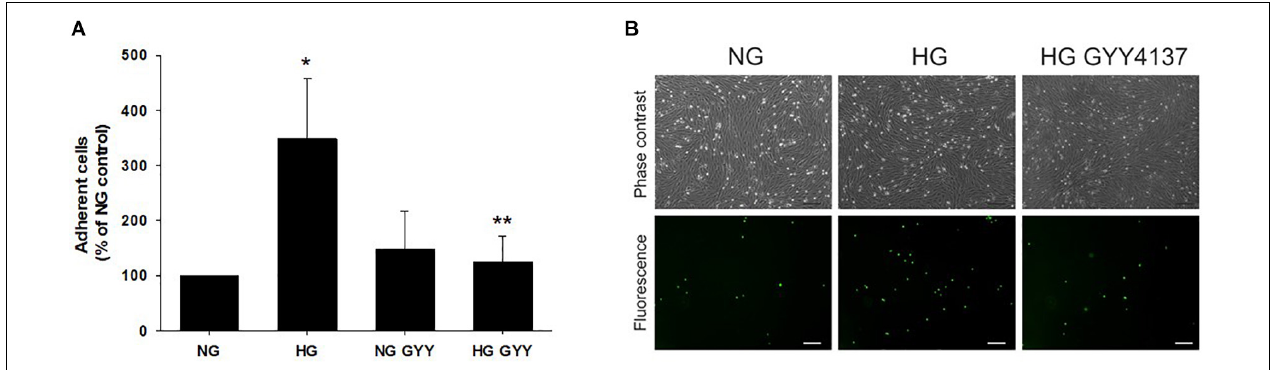
FIGURE 3 | Administration of the slow-release H 2 S donor NaGYY4137 completely attenuated the increased leukocyte adhesion to retinal ECs induced by hyperglycemia. Retinal ECs were incubated with normal (5.5 mmol/L, NG) or high glucose (25 mmol/L, HG) ± NaGYY4137 (500 µ mol/L) for 24 h before examination of leukocyte adhesion under flow (1 dyne/cm 2 ). (A) Number of adherent U937 cells. Data are mean ± SD. * p ≤ 0.001 vs. control, ** p ≤ 0.001 vs. HG, n = 4. One-way ANOVA. (B) Representative bright field, phase contrast (upper panel) and corresponding fluorescence images (lower panel) of adherent U937 cells stained with calcein acetoxymethyl ester adhering to a BREC monolayer. Scale bar, 75 µ m; original magnification, ×